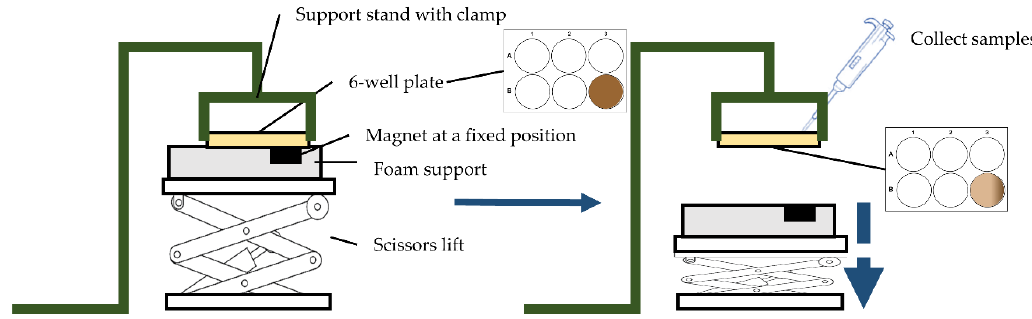
Figure 5. Scheme of the prototype static model used for validation of the magnetic properties of the developed nanoformulations.